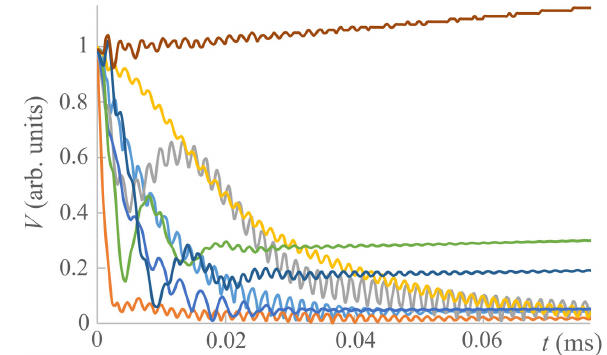
FIG. 9. Dipole mode voltages time dependence for a current 10% above the threshold. Mode configuration is the same as in Fig.